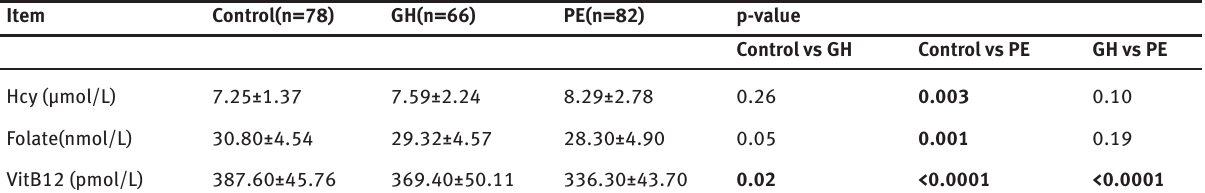
Table 2: Maternal Serum Homocysteine, Folate and vitamin B12 comparison between different groups. Item